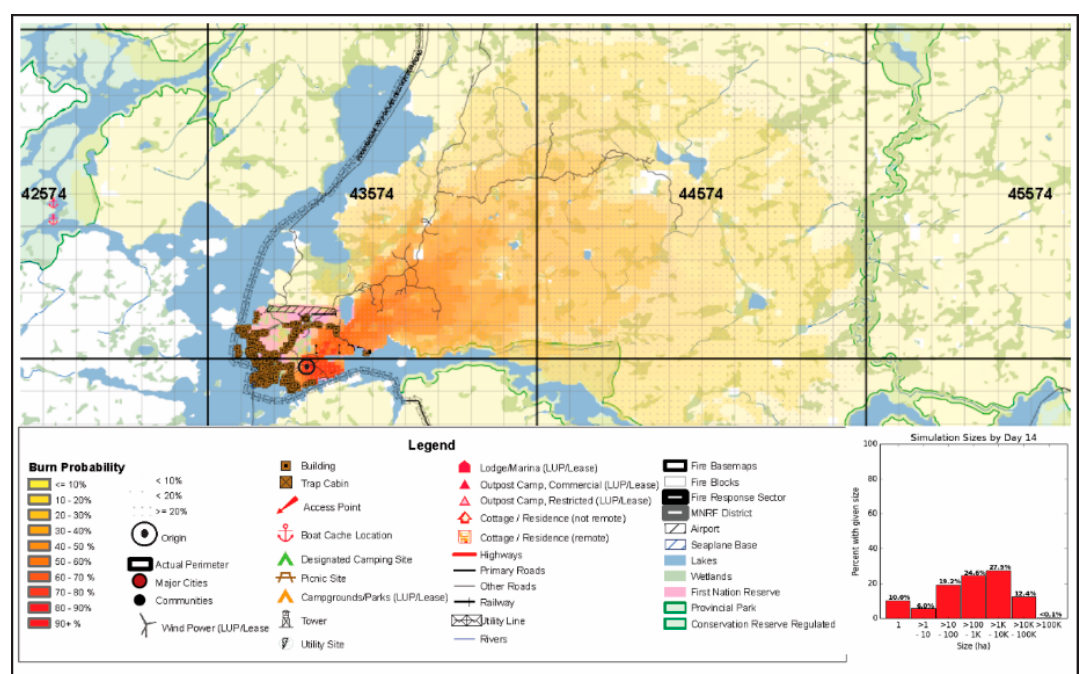
Figure 7. An AFFES 14-day burn probability map from the FireSTARR model.